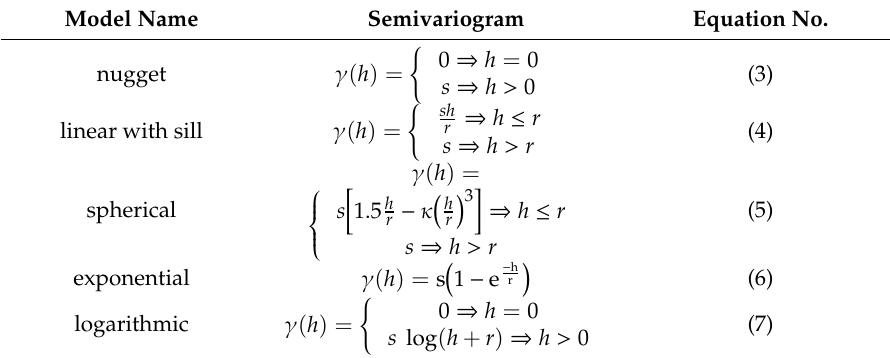
Table 3. Basic semivariogram models.